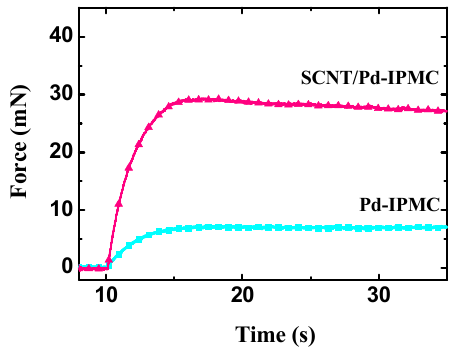
Figure 9. Blocking force curves under 2 V DC voltage in 25 s.